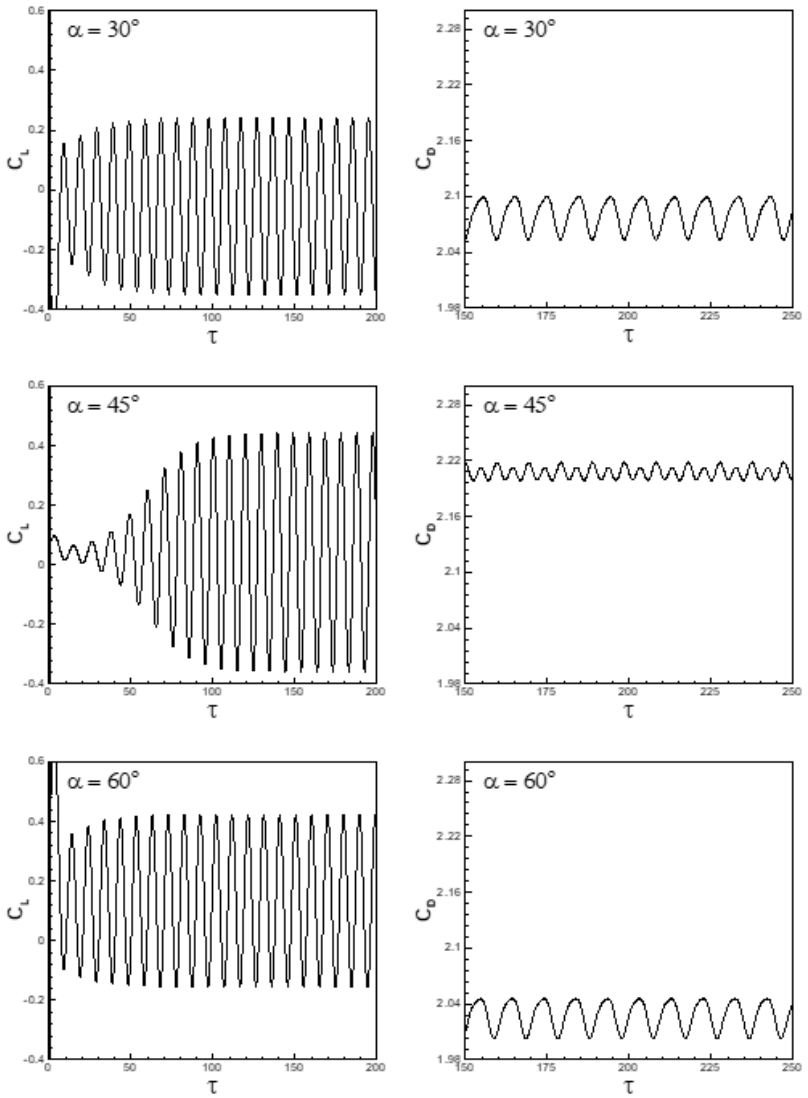
Figure 15. Lift and drag coefficients vs. non-dimensional time at Re = 40, Ri = 0 and 30° ≤ α ≤ 60°. Variations in lift and drag coefficients with non-dimensional time are shown in Fig- ures 16 and 17 for the conditions (60 ≤ Re ≤ 120 and 30° ≤ α ≤ 60°) at a fixed Richardson number Ri = 0.2 to highlight the effects of free-stream orientation and Reynolds number on aerodynamic parameters. It is depicted in Figures 16 and 17 that the flow is found to be an unsteady periodic flow with an initial transition. The initial transition period is found to be more at a free stream orientation α = 45 ° in comparison with free-stream ori- entations 30° and 60°, respectively, for the selected range of Reynolds number. The growth rate of instability is lower at α = 45 ° than for α = 30 ° or α = 60 ° owing to the symmetry of the flow configuration on either side of the free-stream orientation. It is seen from Figure 16 that the amplitudes of the lift coefficient are larger at α = 45 ° than at α = 30 ° and 60° for the entire range of Reynolds number. It is also seen from Figure 16 that the amplitudes of the lift coefficient increase with an increase in Reynolds number for the selected range of free-stream orientations. On the other hand, smaller amplitudes of drag coefficient are found for α = 45 ° than at α = 30 ° and α = 60 ° for the entire range of Reynolds number (Figure 17). It is also observed from Figure 17 that the mean values of the drag coefficient increase with an increase in Reynolds number. The amplitudes of the drag coefficient also